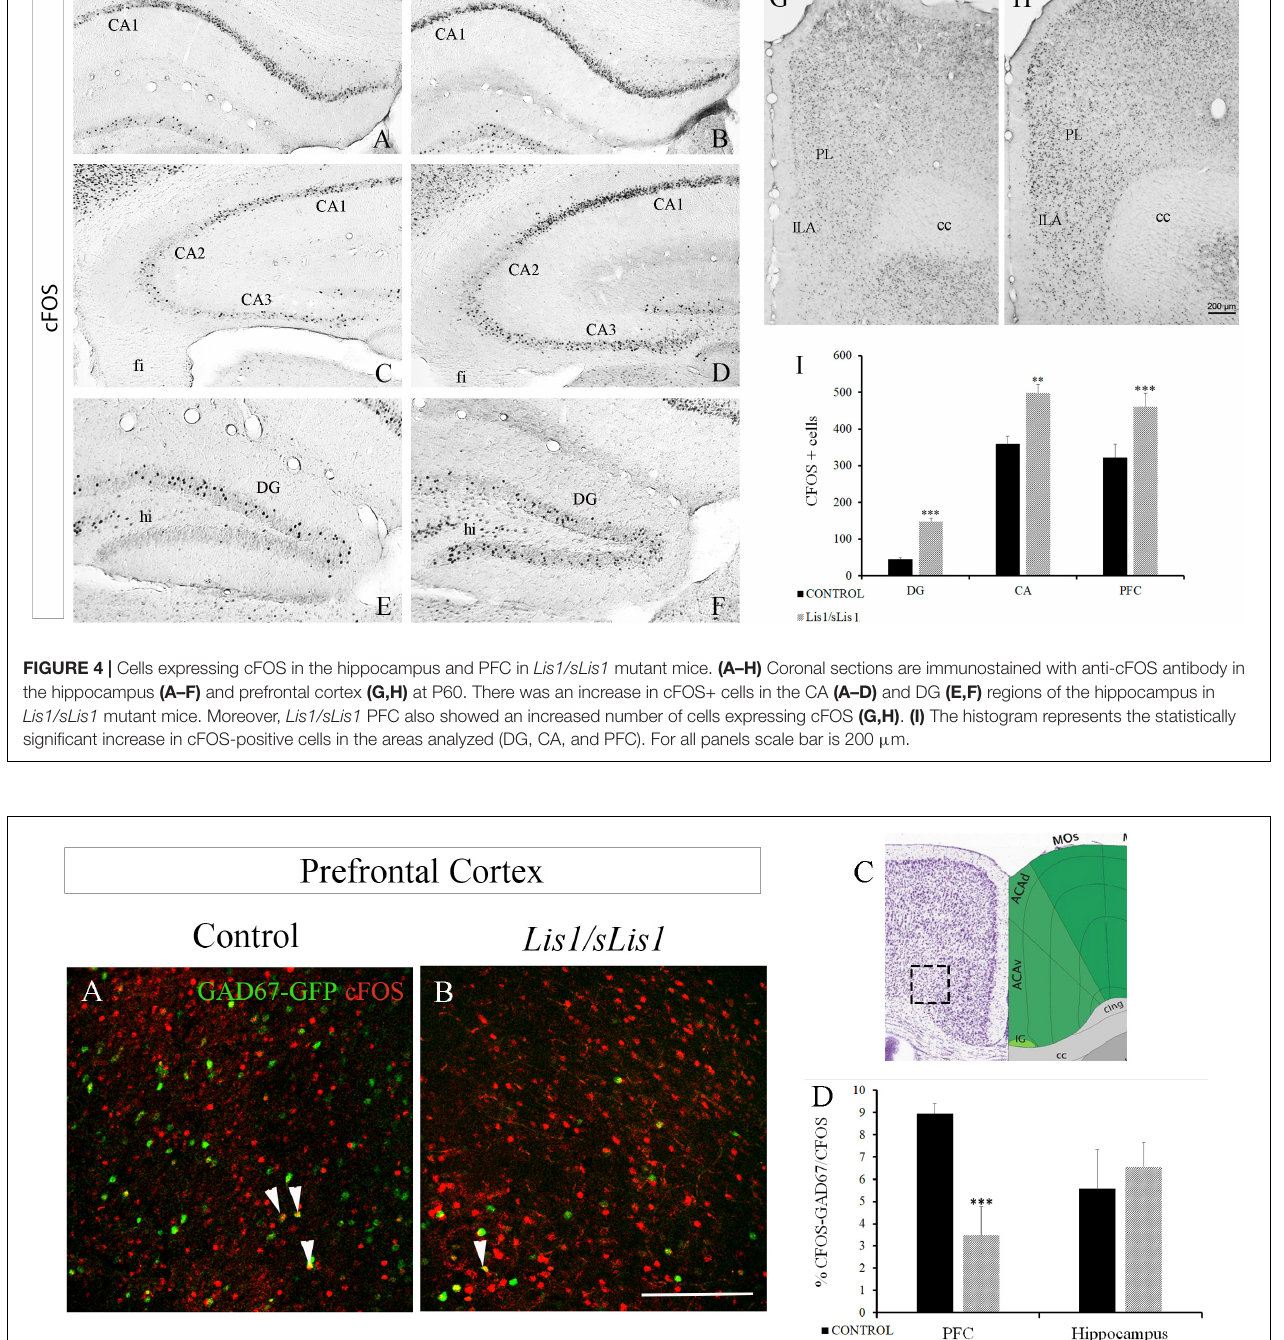
FIGURE 5 | Study of the number of co-expressing cFOS and GAD67 cells at P60 in the mPFC of control and Lis1/sLis1 mutant mice. (A,B) The number of cells co-expressing cFOS and GAD67 in the mPFC area of Lis1/sLis1 mutant mice was decreased compared to control mice. (C) The image was taken from the Allen Brain Atla s showing the approximate area of panels (A,B) , where the cells were counted. (D) Histogram indicating the average number of co-expressing cFOS and GAD67 cells ± SE in the young-adult mPFC and hippocampus. Scale bar is 200 µ m.